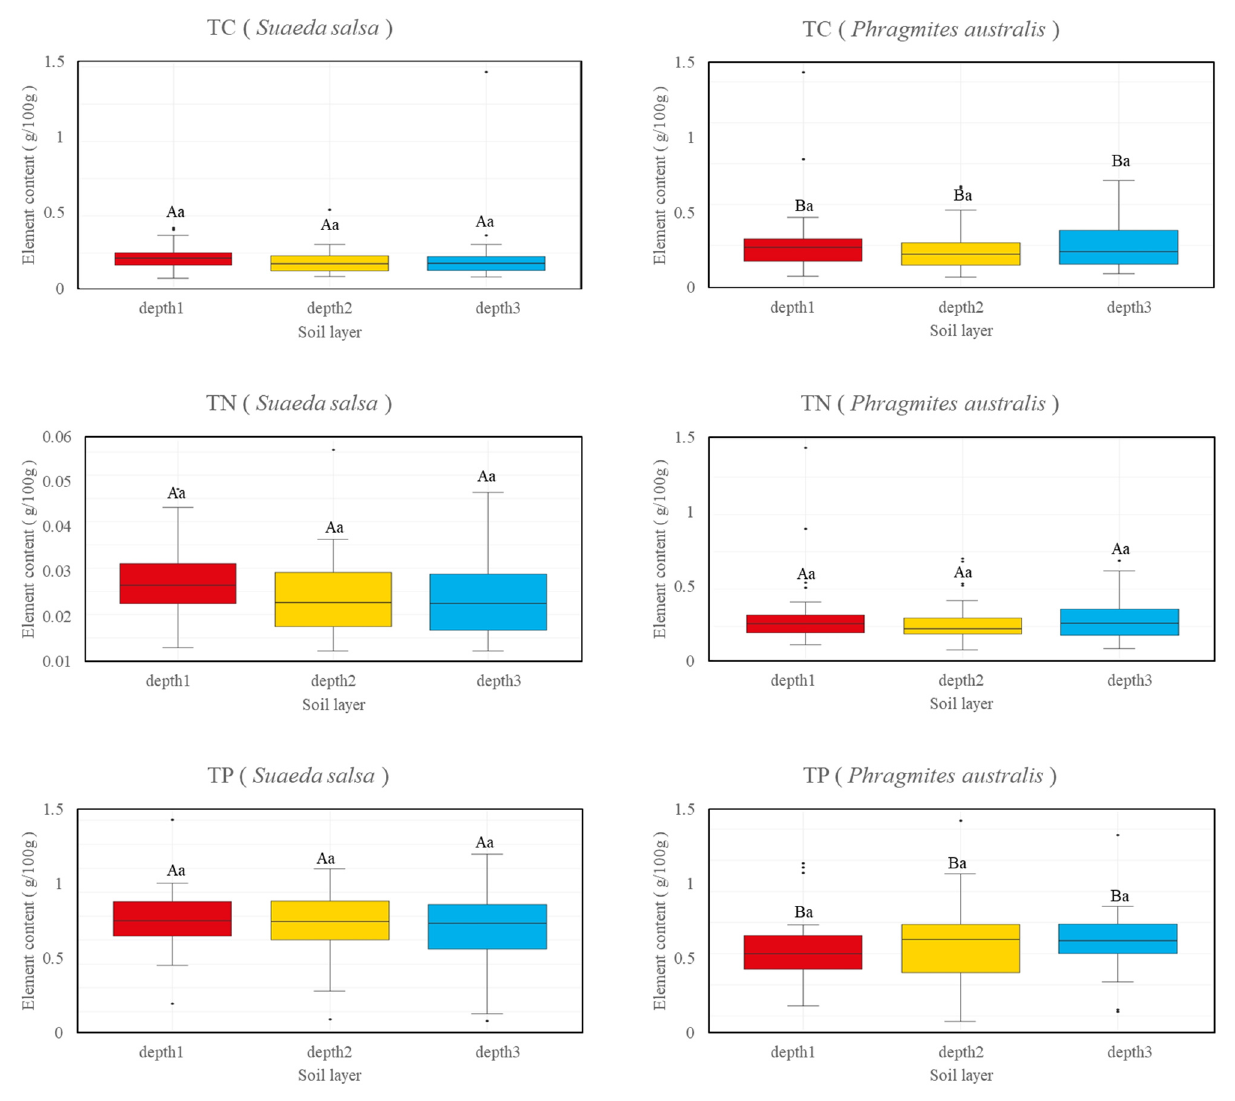
Figure 2. Total carbon (TC), total nitrogen (TN), and total phosphorus (TP) contents of the inter-root soils of two plants, S. salsa and P. australis (depth 1 = 0–20 cm, depth 2 = 20–40 cm, and depth 3 = 40–60 cm). Notes: different capital letters (A, B) represent significant differences in the soil elements under the different vegetation types, and lowercase letters (a) represent nosignificant differences in the soil elements in the different soil layers of the same vegetation type.